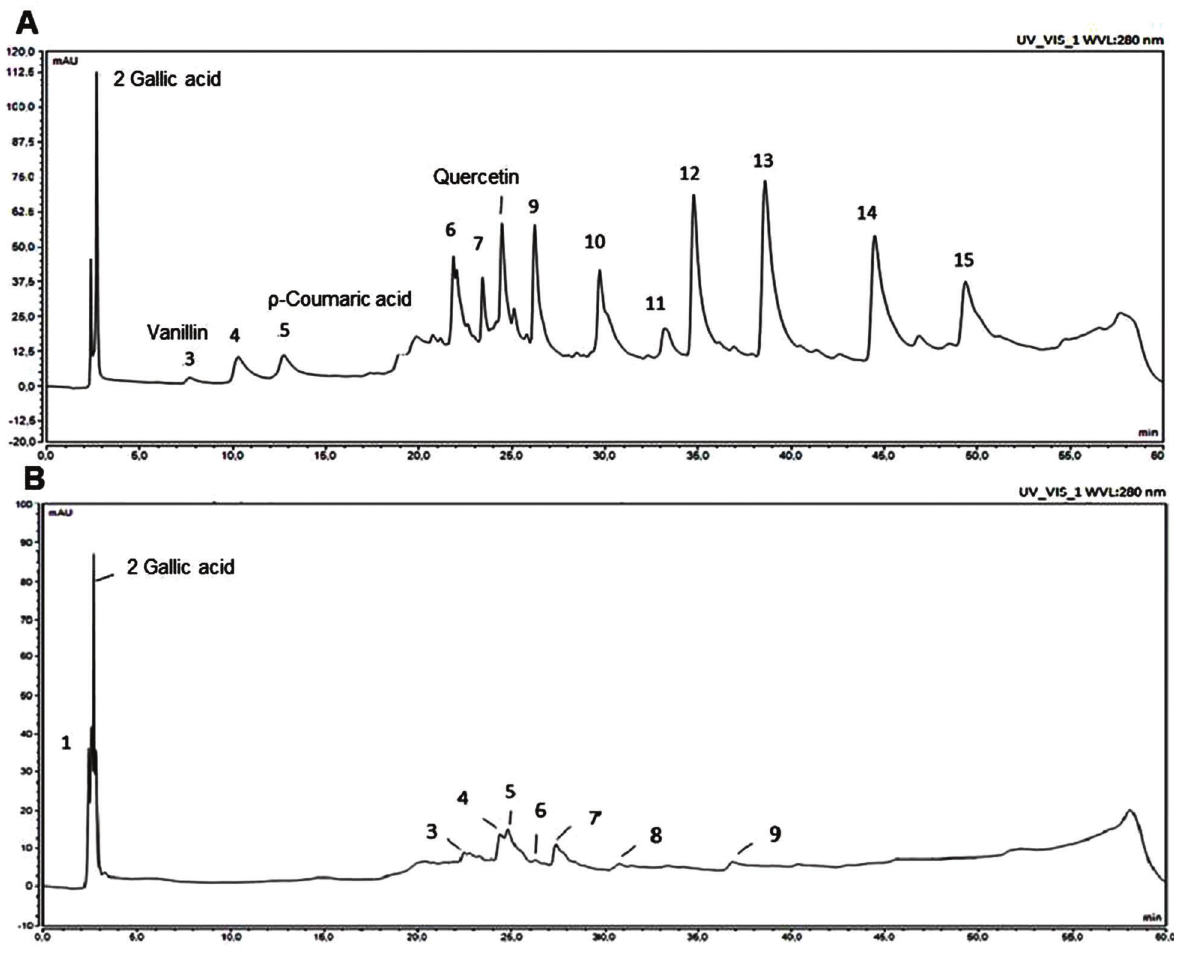
Figure 1 . HPLC-DAD (280 nm) chromatograms of the ethanolic extract of propolis using a C18-reversed phase column at 40°C. A , M. quadrifasciata quadrifasciata peaks: 2-gallic acid (Rt=2.68 min), 3-vanillin (Rt=7.67 min), 5- r -coumaric acid (Rt=12.73 min), and 8-quercetin (Rt=24.45 min). B , T. angustula peak: 2-gallic acid (Rt=2.69 min). Rt: retention time. The peaks not cited are from unidenti- fi ed